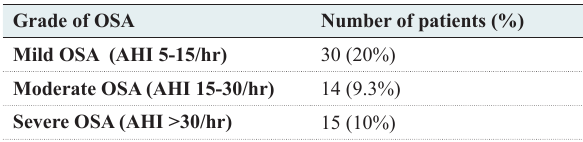
Table 2: Correlation of variables with OSA and